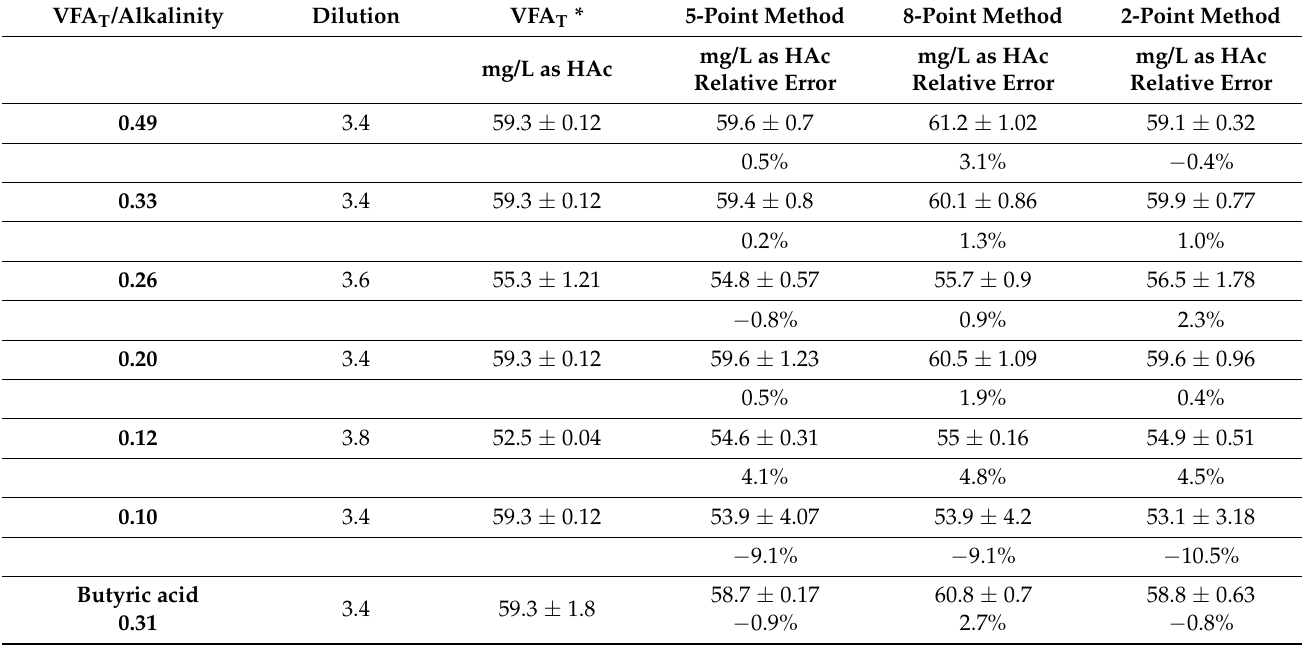
Table 2. Titration results of six synthetic solutions and the simulated butyric acid solution, showing the calculated VFA concentration and relative error (%), as interpreted by the three titration